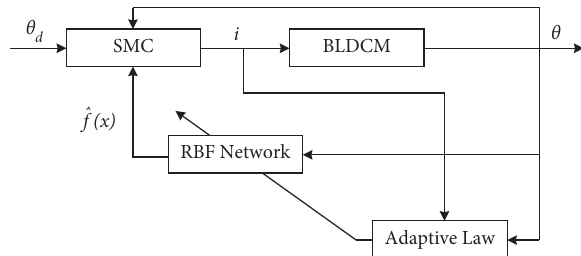
Figure 4: Design scheme of synovial controller based on the neural